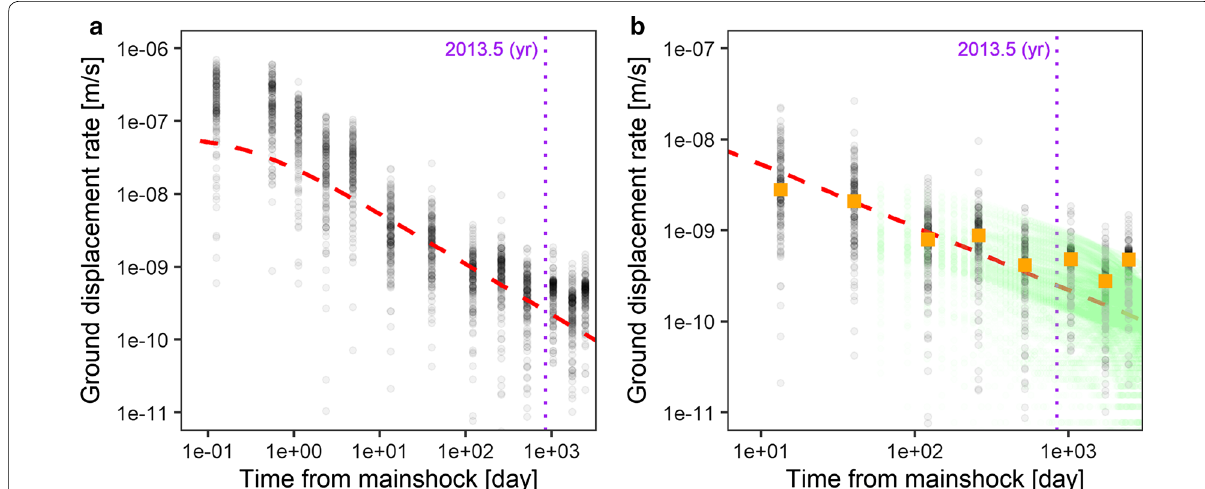
Fig. 8 a Evolution of the vertical ground displacement rates after the 2011 Tohoku Earthquake. The red dashed line represents the best-fit to the observations based on Eq. (1) using the same p d and c d as those in the horizontal case (Fig. 2). The violet dotted line shows a reference time in mid-2013 for possible change of the dominant mechanism of the postseismic deformation (Yamaga and Mitsui 2019). b Enlarged figure for a comparison with the Maxwellian viscoelastic simulation (green points) as Fig. 7. The orange squares represent median values of the displacement rates for each time